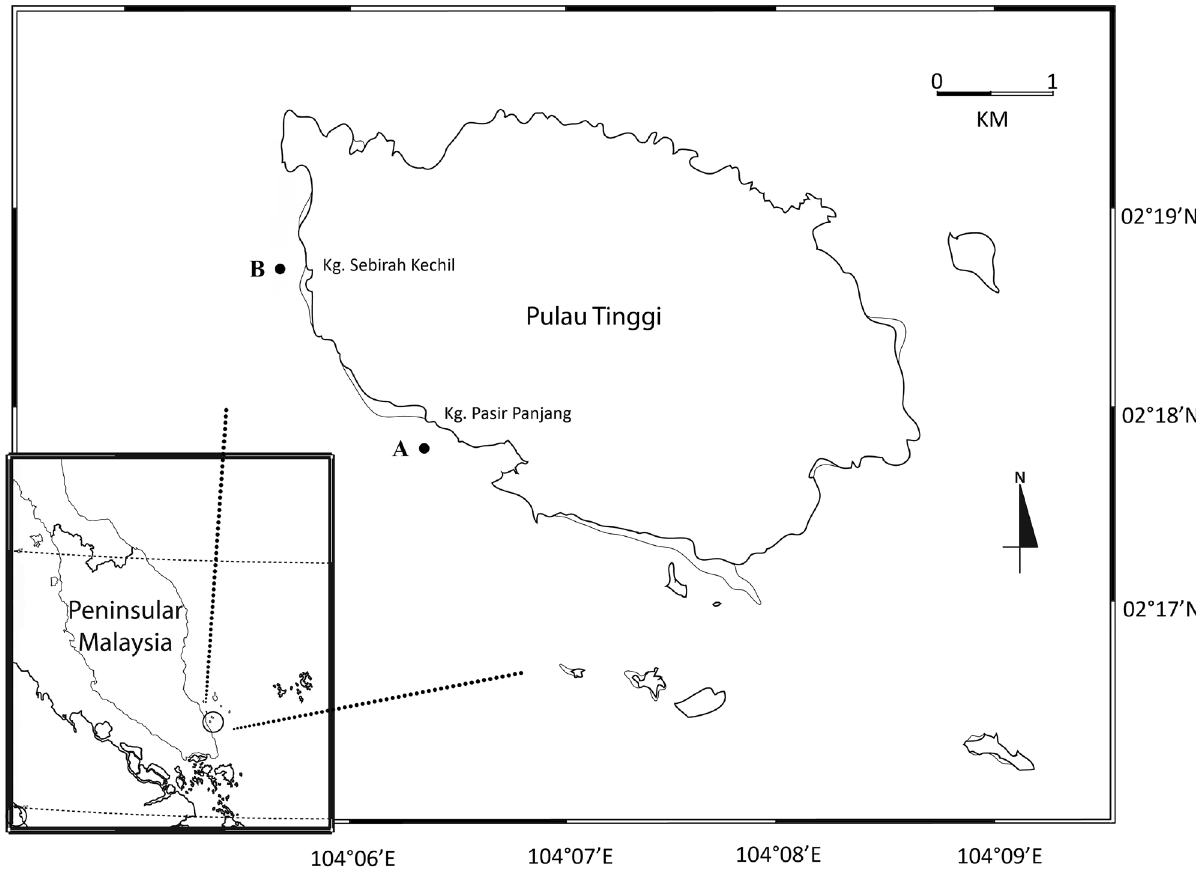
Figure 1. Map of the study area. A. Kampung Pasir Panjang. B. Kampung Sebirah Kechil, Pulau Tinggi, Sultan Iskandar Marine Park,